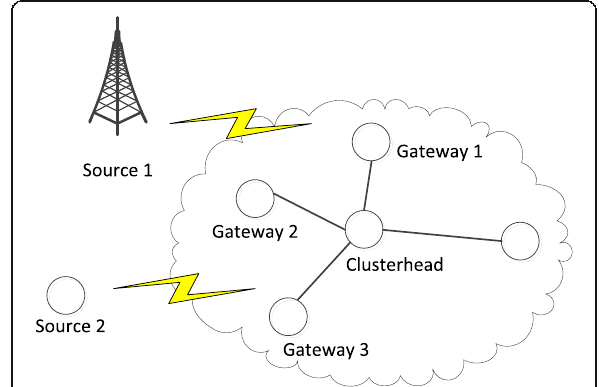
Fig. 1 Cluster-crossed relaying scenario. In this framework, the communication is considered to be cluster-crossed. Sources are either base station, head nodes, or gateway nodes of other clusters. Relays are head nodes and gateway nodes in the same cluster of the destination, shown as Fig. 1